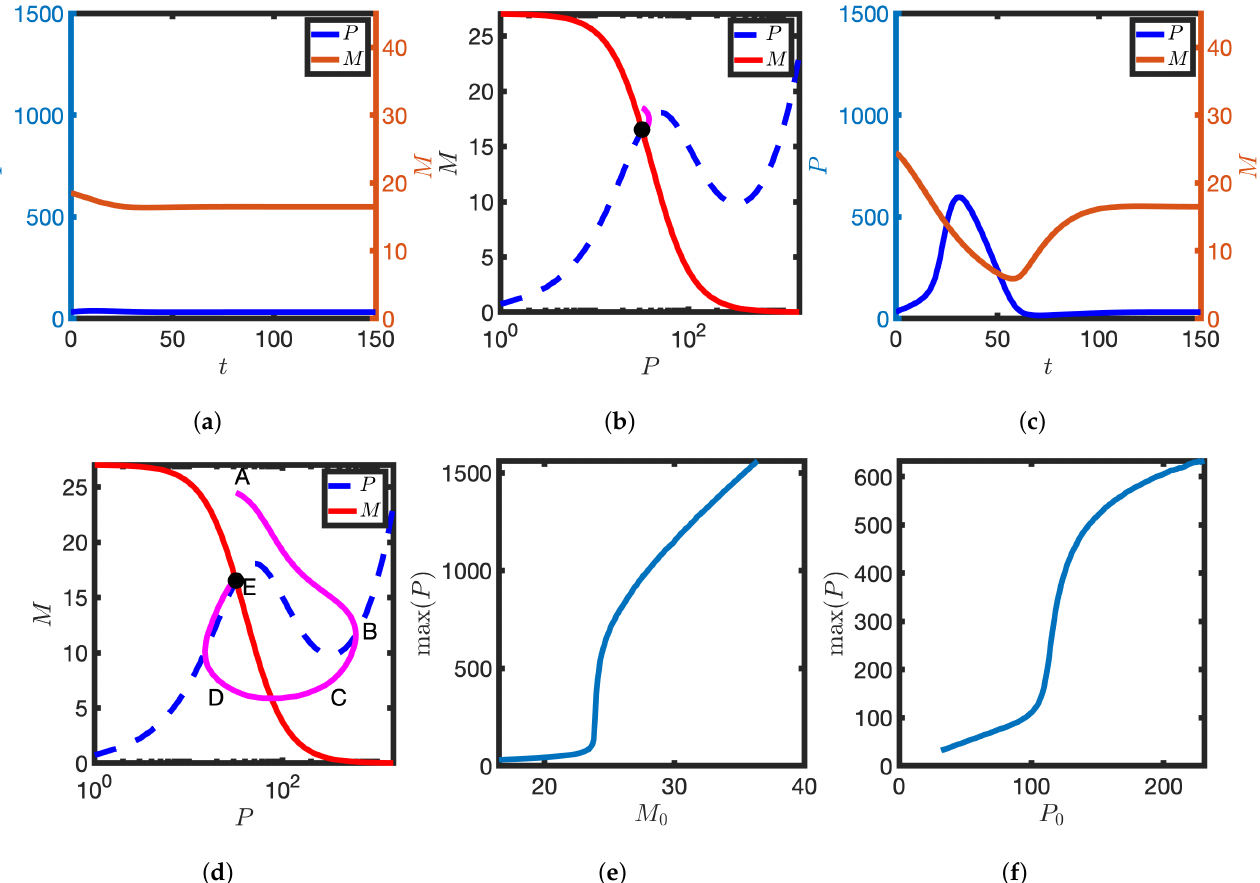
Figure 3. Excitable solutions in the case of an intermediate transcription rate. ( a , b ) Solution dynamics upon making a small initial perturbation about the steady state. P and M are plotted against time, t , ( a ) and in the phase plane ( b ). ( c , d ) Solution dynamics upon making a large initial perturbation about the steady state. Other details as in ( a , b ). ( b , d ) Magenta lines represent solutions in the PM phase plane. P nullclines (dashed blue lines), M nullclines (solid red lines), steady states (black dots). ( e ) max ( P ) is plotted against the initial number of mRNA molecules, M 0 . ( f ) max ( P ) is plotted against the initial number of protein molecules, P 0 . k 1 = 0.81. Equation (2) were solved numerically. Other parameter values as